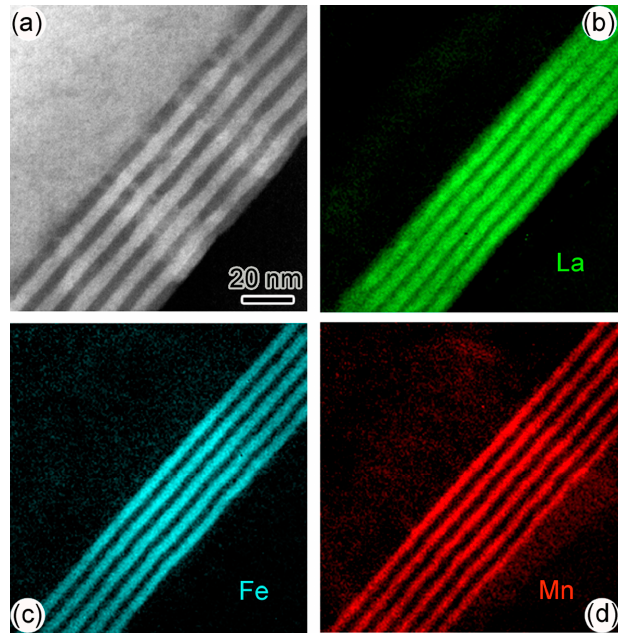
Figure 7. ( a ) Low-magnification HAADF image of sample-III; ( b – d ) are the element mapping images of La, Fe, and Mn in sample-III.